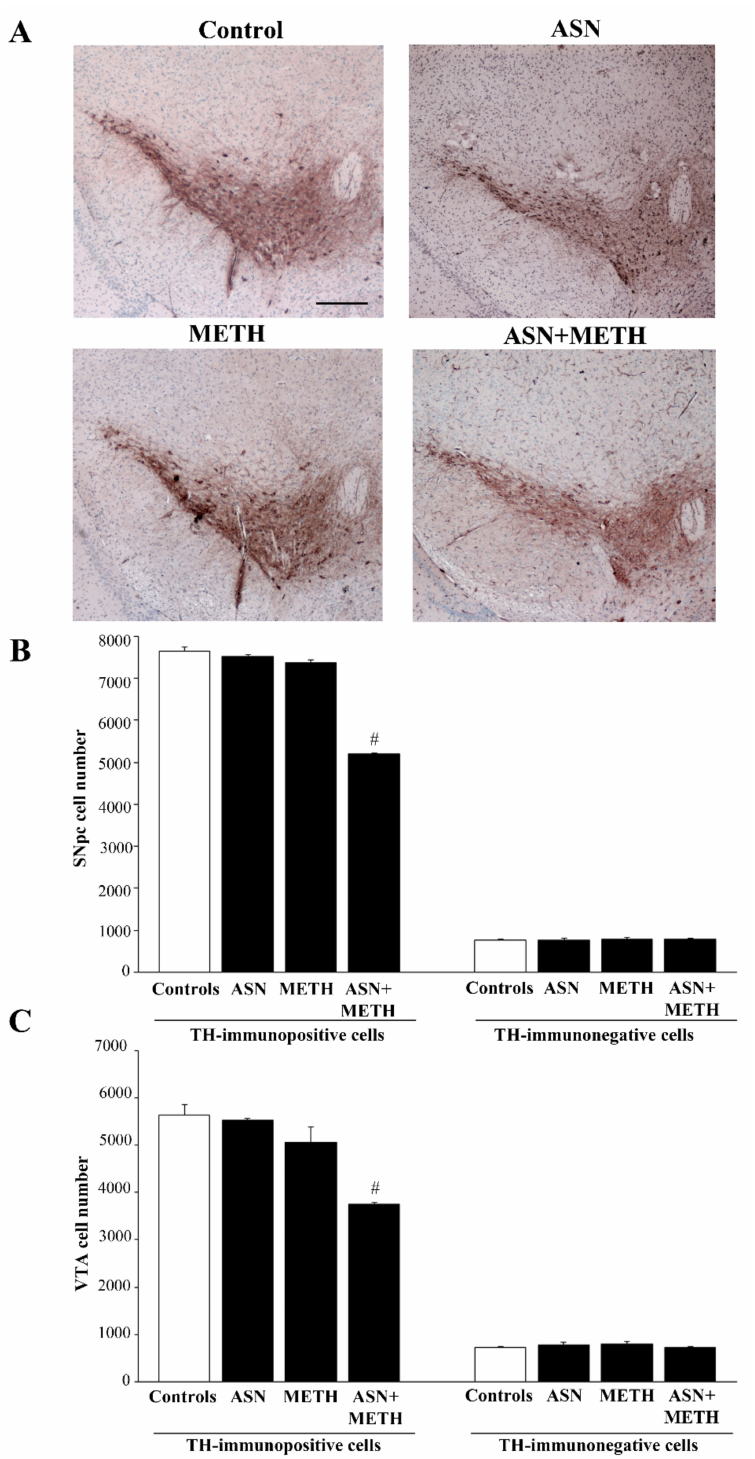
Figure 6. ASN extends METH toxicity to cell bodies within SNpc and VTA. ( A ) Represen- tative pictures of TH immunostaining within the midbrain from a control mouse and from mice treated with ASN (1000 mg/kg × 4), or METH (5 mg/kg × 4, 2 h apart), or combined ASN (1000 mg/kg × 4) + METH (5 mg/kg × 4, 2 h apart). The stereology-like count of TH- immunopositive and TH-immunonegative cells within SNpc ( B ) and VTA ( C ) following various treatments is reported. # p < 0.05 compared with Controls and METH. Scale bar = 200 µ